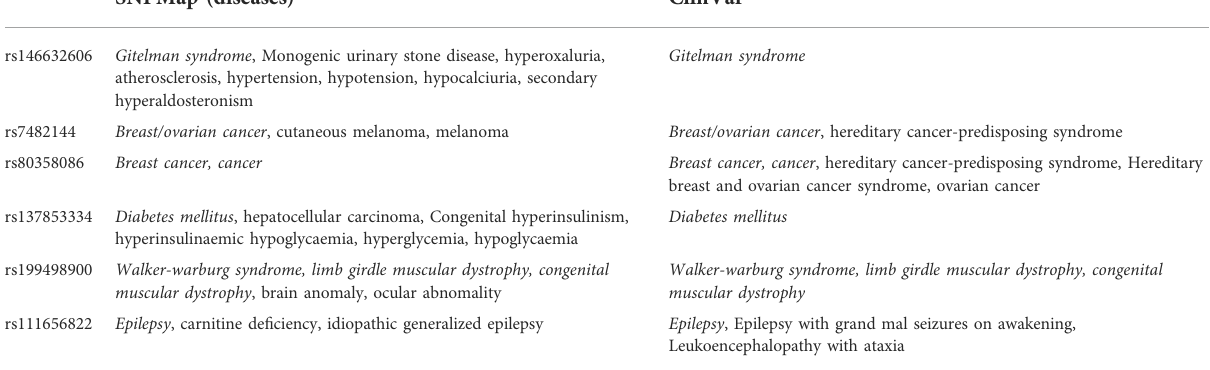
TABLE 2 Some selected SNPs and comparisons of their concepts under SNPMap and